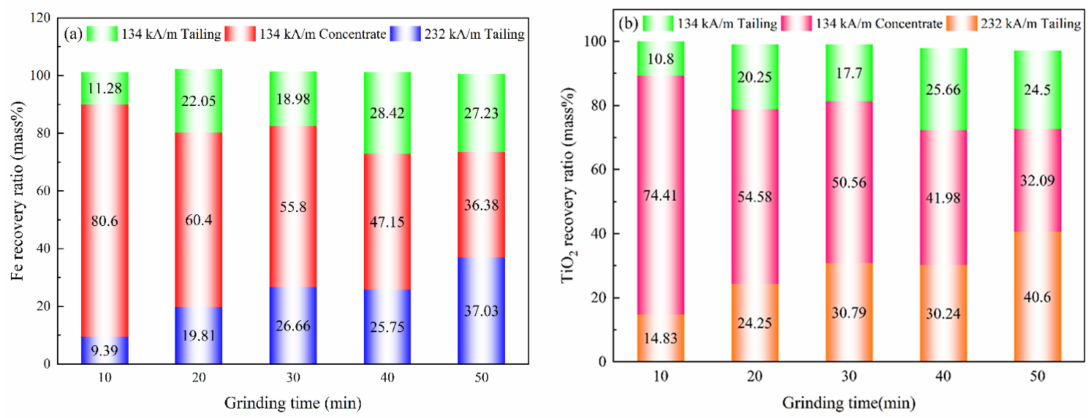
Figure 12. Effect of grinding time on recovery ratio of ( a ) Fe and ( b ) TiO 2 .